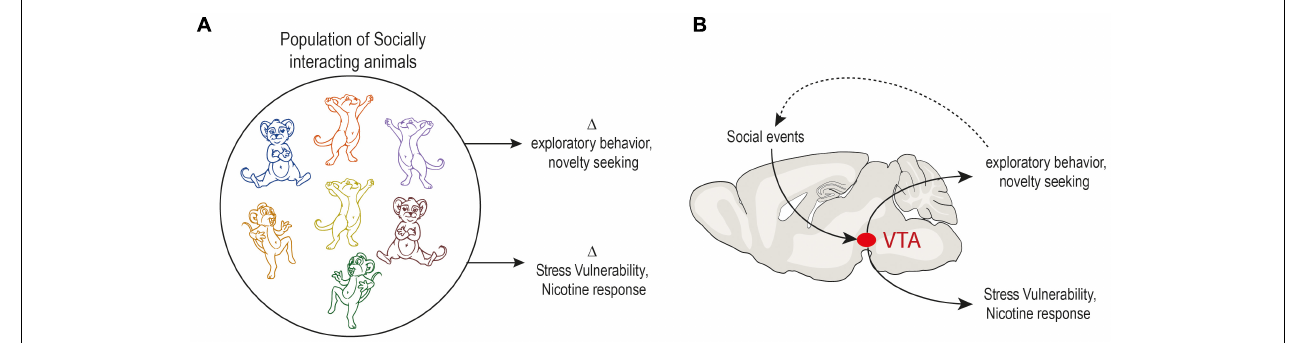
FIGURE 3 | Model of behavioral adaptation in response to social context through dopaminergic system. (A) Traits can be viewed as stable individual expressions of a behavioral outputs or preferences – with high inter-individual variability but low intra-individual variability. In a population of animals living in a group, in the same environment, individuals adapt to their social environment. In parallel, traits emerge in a series of non-social behaviors such as exploratory behavior or novelty seeking. Differences in response to stress or drugs such as nicotine are also observed. (B) Diagram illustrating a possible mechanism for generating inter-individual variability. Adaptations as a consequence of individual social experience impact dopaminergic system and lead to differences in individual behavior. In turn, these behavioral differences feed forward into changes in an individual’s interactions with the environment. This loop allows a social profile to be adjusted to another behavioral profile, for example exploration level. The same type of mechanism could allow the emergence of variability in vulnerability to stress and response to